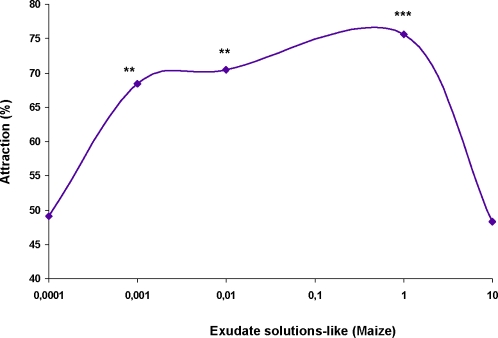
Responses of Coquillettidia in two choice-olfactometer to the mixture mimicking Zea mays and Typha latifolia root exudates.χ2 test for significant differences between compound concentrations attractiveness. ***, p<0.001; **, p<0.01. At least 80 larvae have made a choice in each experiment.